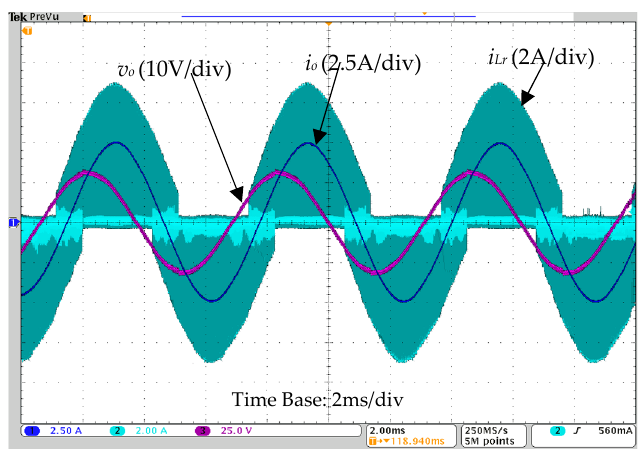
Figure 16. Experimental waveforms of ARSI with dead ‐ time compensation when the modulation index is 0.4 in an open ‐ loop configuration.